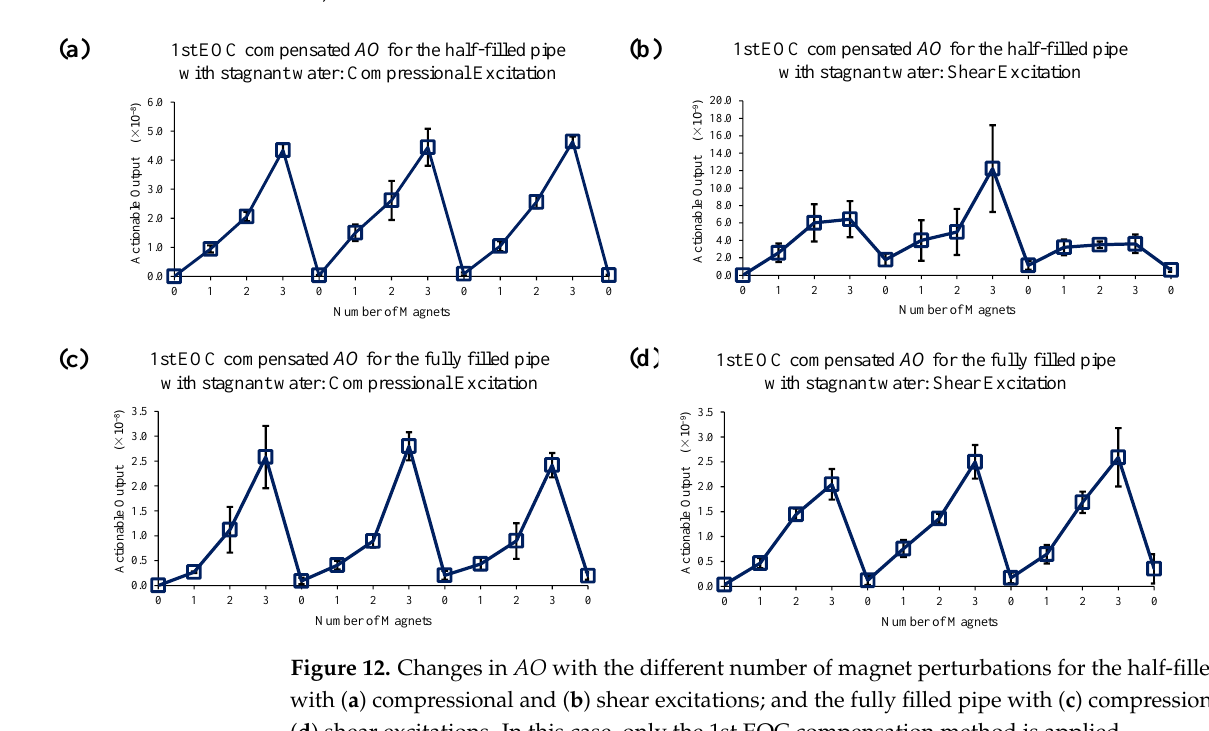
sensitivity improvement are preserved in the case of dynamic liquid-boundary conditions, i.e., with water flow.